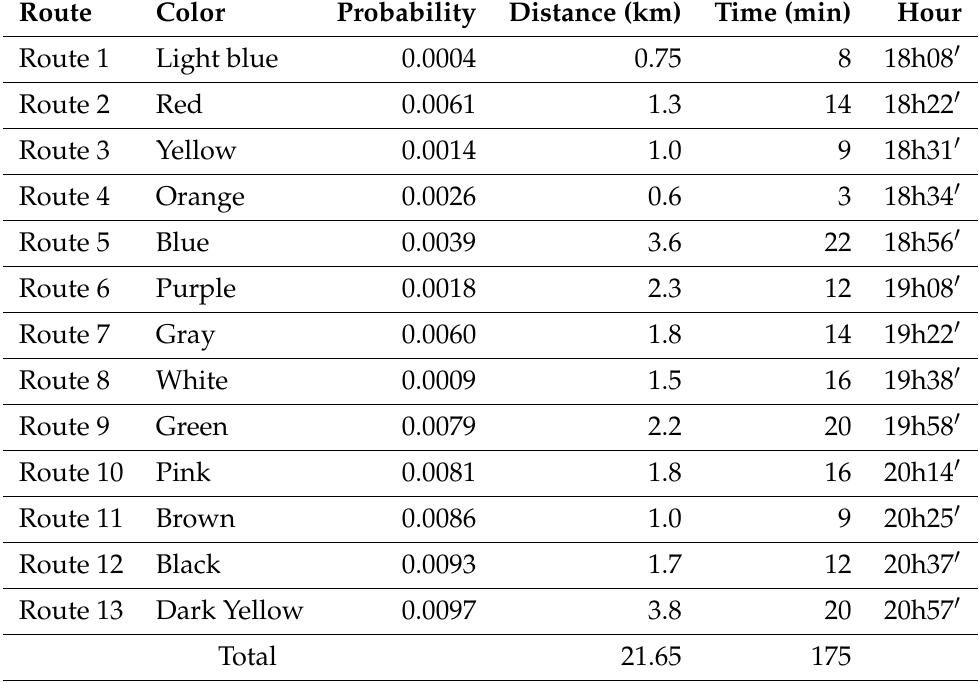
Table 3. Patrol route selection data from expert decision.